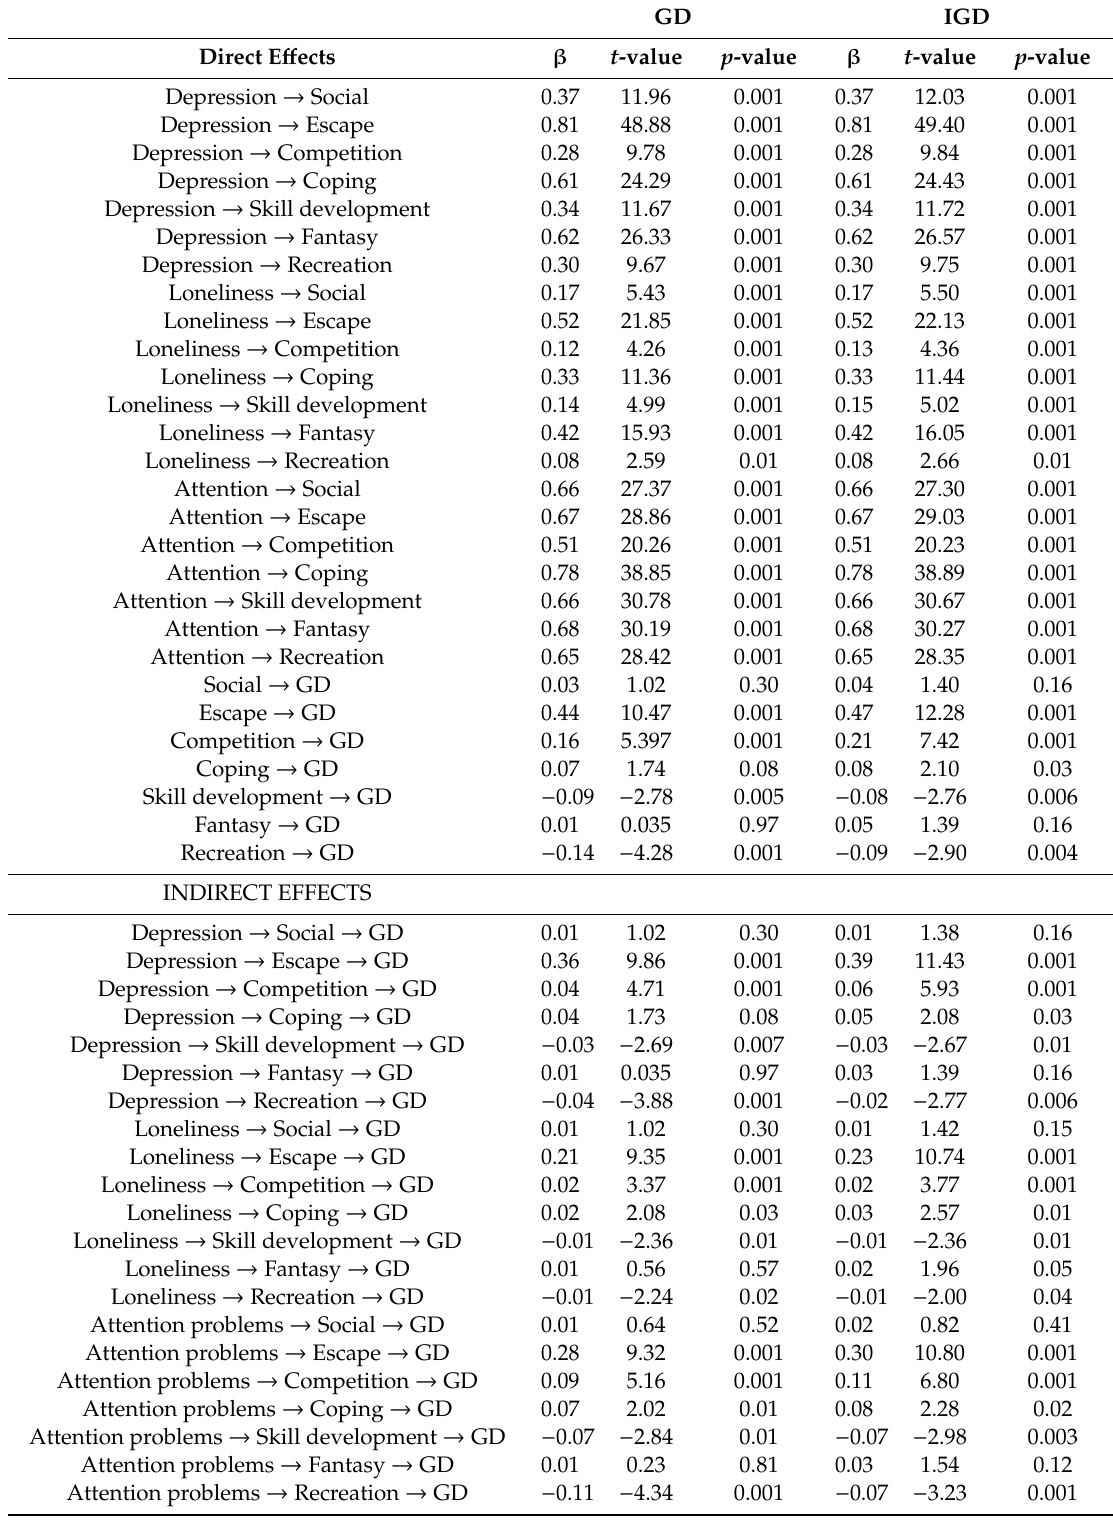
Table 2. Summary of the mediation analysis according to the World Health Organization (WHO) framework for Gaming Disorder (GD) and American Psychiatric Association (APA) framework for Internet Gaming Disorder